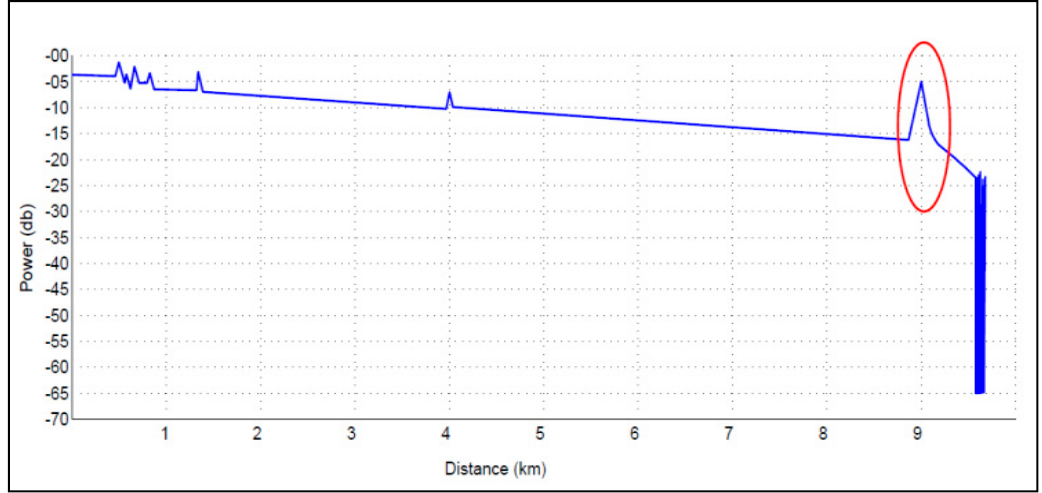
Figure 7. The improving FPMT circuit detected a fiber break pattern shape in event 1.